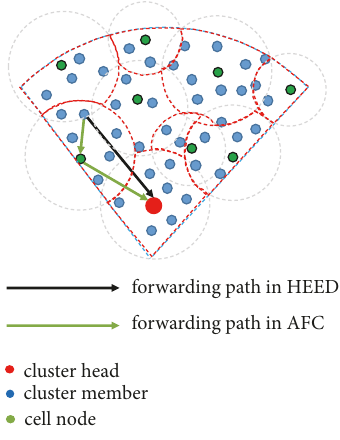
Figure 4: The comparison of data forwarding in HEED and AFC: CMs forward the data to the CH directly in HEED, whereas the CNs in AFC collect the data from CMs and then forward it to the CH.